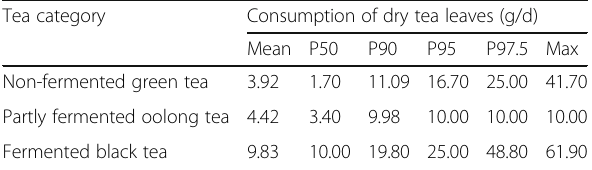
Table 4 Detailed consumption data of tea consumers in China Tea category